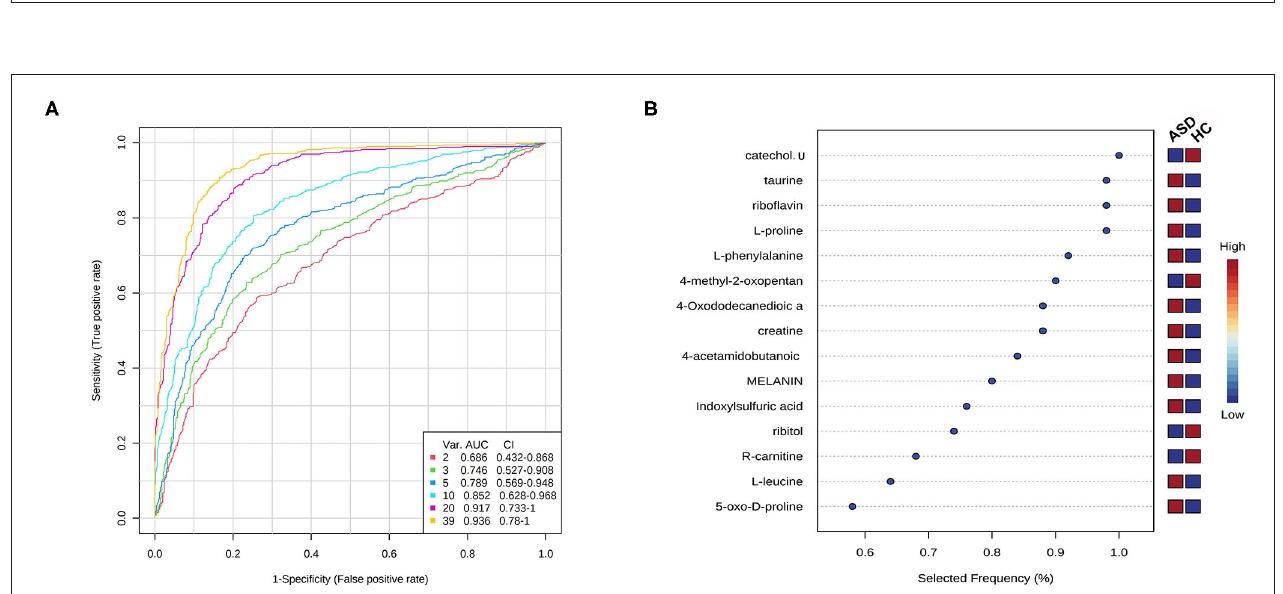
FIGURE 4 | Potential biomarker analysis using SVM algorithm. (A) ROC curves from different biomarker models using different numbers of features. (B) The top 10 significant metabolites ranked based on their frequencies of being selected during cross validation.